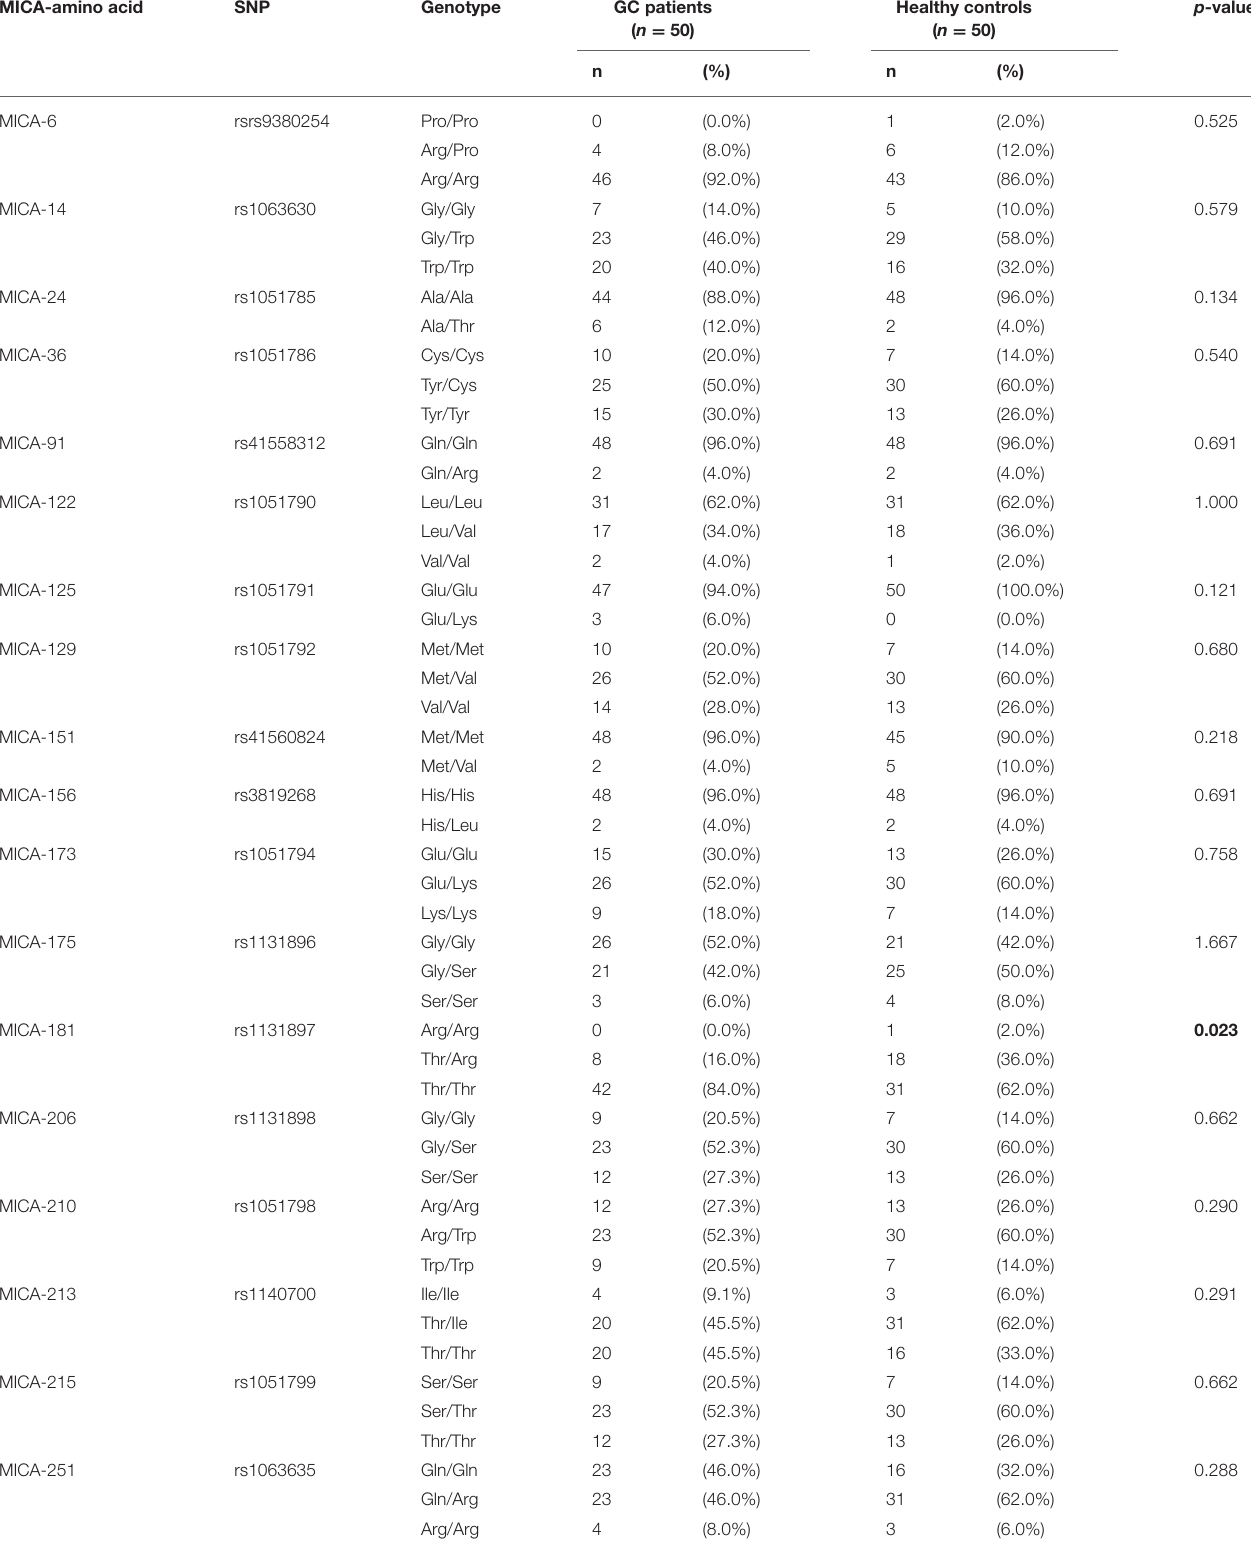
TABLE 3 | MICA amino-acids genotypes of GC patients and healthy controls. MICA-amino